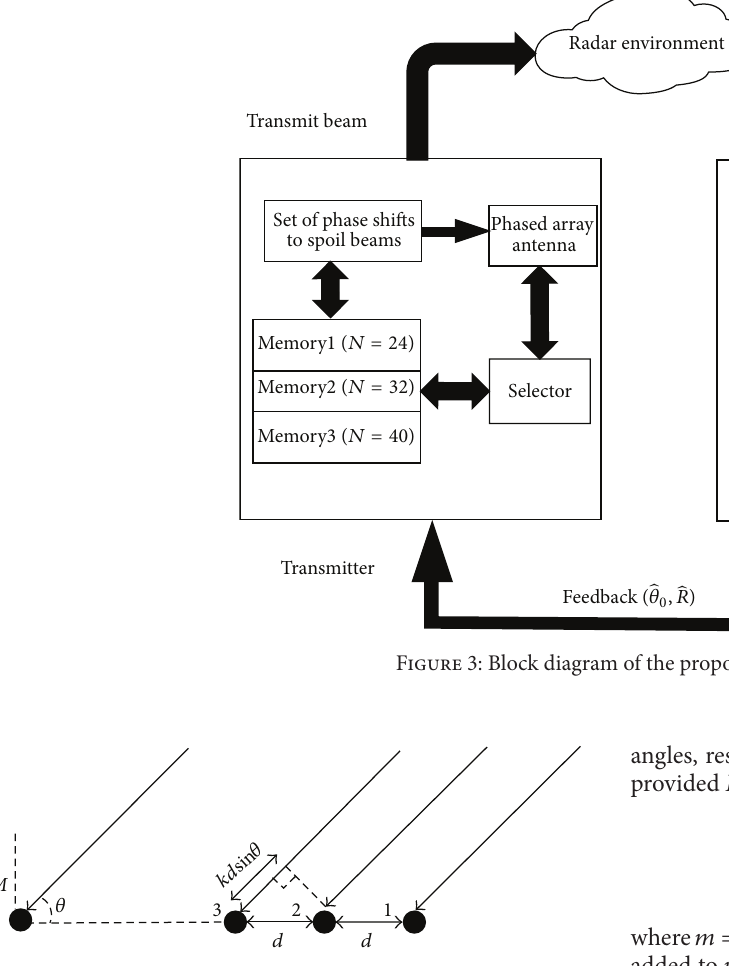
Figure 4: A uniform linear receiving array with 𝑀